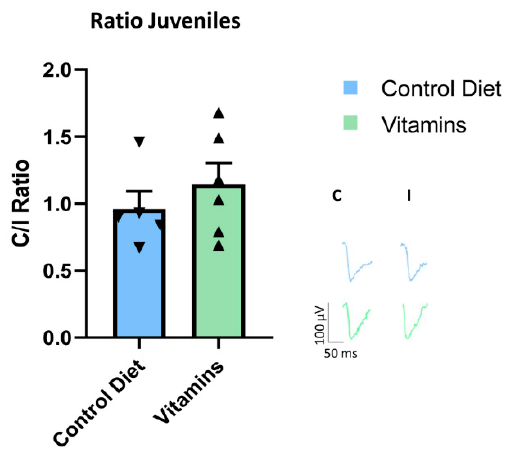
Figure 2. Vitamin treatment did not block plasticity during the critical period. Young rats that received vitamins C and E supplementation (SV, n = 6) did not show any difference of OD plasticity in comparison with young rats fed with the standard diet (SC, n = 5) ( t -test; SV, ratio = 1.14 ± 0.15 vs. SC, ratio= 0.96 ± 0.13, p = 0.41). Error bars represent SEM.